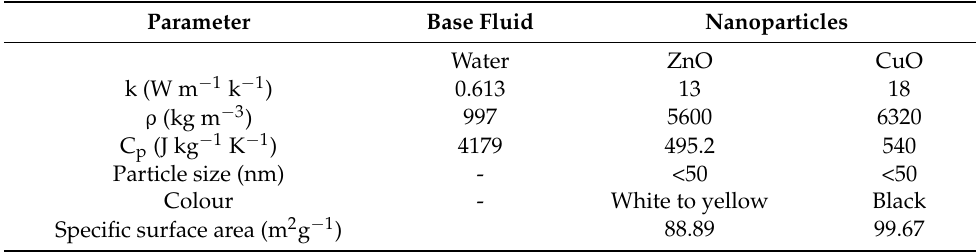
Table 1. Thermophysical properties of base fluid and nanoparticles. Parameter Base